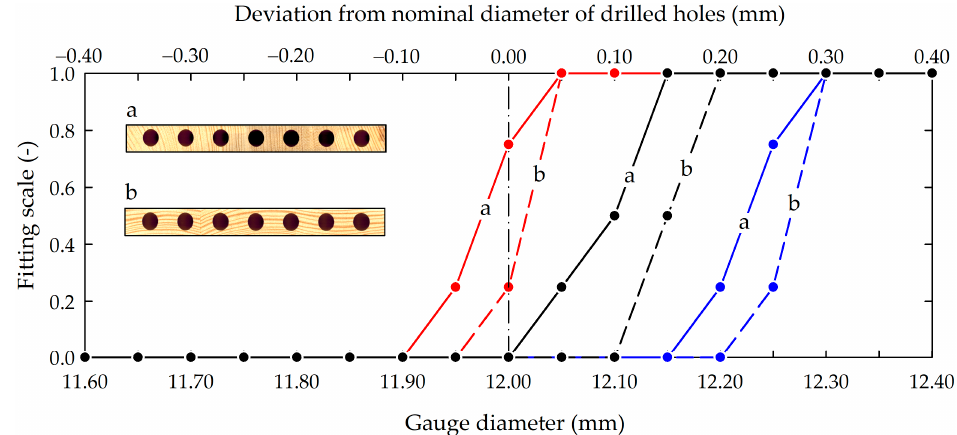
Figure 5. Results of the effective diameter measurements by plug gauge method according to grain pattern and moisture content of Scot’s pine planks (a, b—radial and tangential grain pattern, respectively; black dots and lines—conditions corresponding to RH = 60% (reference); blue dots and lines—conditions causing swelling of samples (increased air RH to 85%); red dots and lines—conditions causing shrinking of samples (decreased air RH to 35%); dots represents modal values ( n = 7); dash-dot line–nominal diameter of drilled holes ( d = 12 mm); limit values of fitting scale: 0—loose running (larger clearance, can be assembled), 1—interference fits (press fits, cannot be assembled).